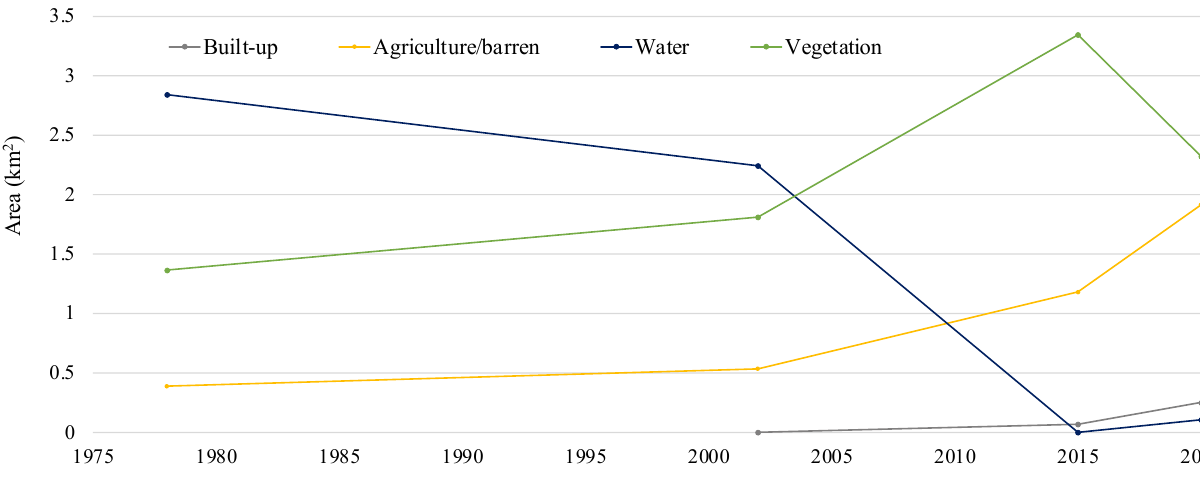
Figure 4. Landcover changes in Teratai Village.